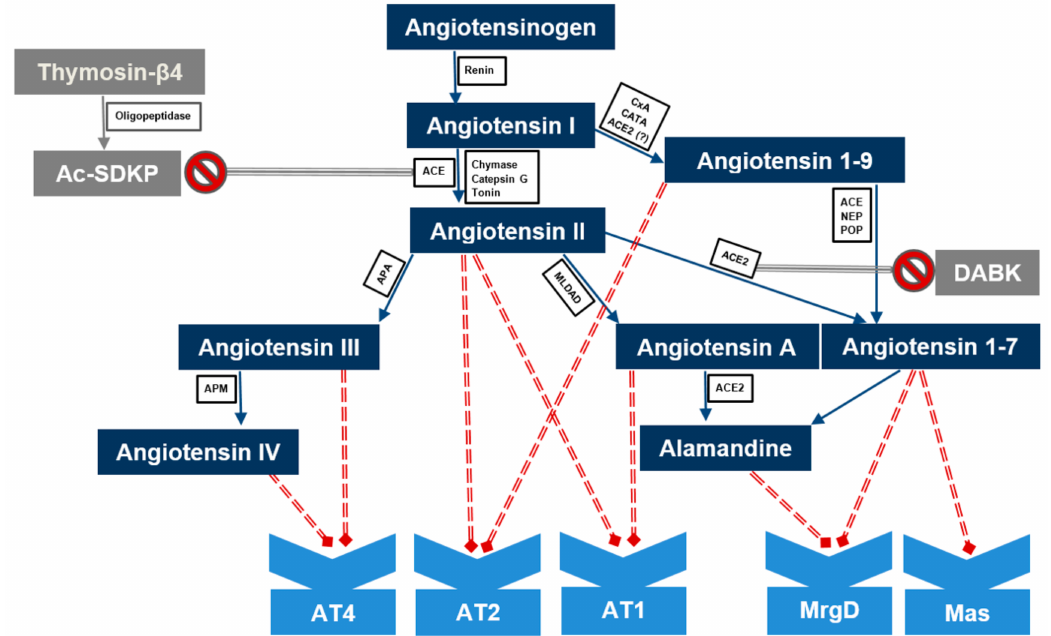
Figure 1. Renin–angiotensin system. ACE—angiotensin-converting enzyme; ACE2—angiotensin- converting enzyme 2. Ac-SDKP—N-acetyl-seryl-aspartyl-lysyl-proline; DABK—des-Arg 9 -bradykinin; CxA—carboxypeptidase A; CATA—cathepsin A; NEP—neprilysin; POP—propyl